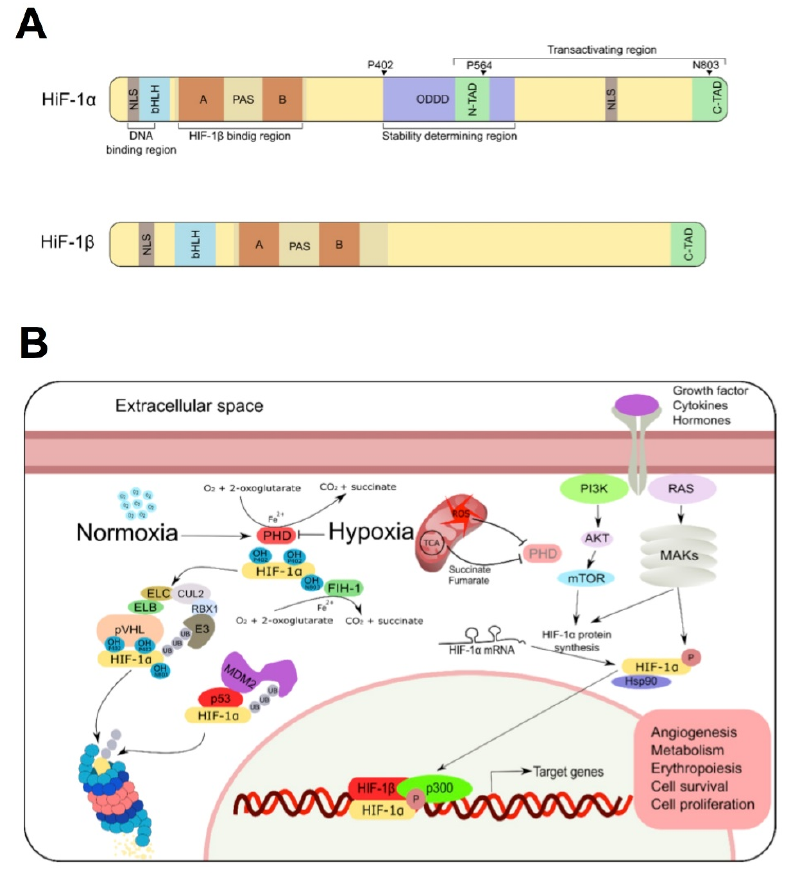
Figure 1. Structure and regulation of HIF. ( A ) Schematic representation of human HIF-1 α and HIF- 1 β structure. Both proteins form part of the HLH–PAS transcription factor family and contain a N-terminal bHLH domain (implicated in DNA binding) and two PAS domains (responsible of its dimerization). HIF-1 α contains an oxygen-dependent degradation domain (ODDD) that mediates oxygen-regulated stability, and two transactivation domains (TAD), that mediate its transcriptional activity and its stability. ( B ) In normoxia, HIF-1 α is subjected to oxygen-dependent hydroxylation by Prolyl hydroxylase domain (PHD) hydroxylases, conducting HIF-1 α to ubiquitination by the von Hippel-Lindau protein (pVHL) and proteasomal degradation. MDM2/p53 are also involved in ubiq- uitination and degradation of HIF1 α protein in a pVHL-independent manner. Under low oxygen levels (as well as some metabolites of TCA cycle), PHD is inhibited, HIF-1 α translocates to the nu- cleus and promotes the activation of target genes. Transactivation of HIF-1 α could be also induced by PI3K/MAPKs signaling pathways upon activation of some growth factor, hormones and cyto- kines.